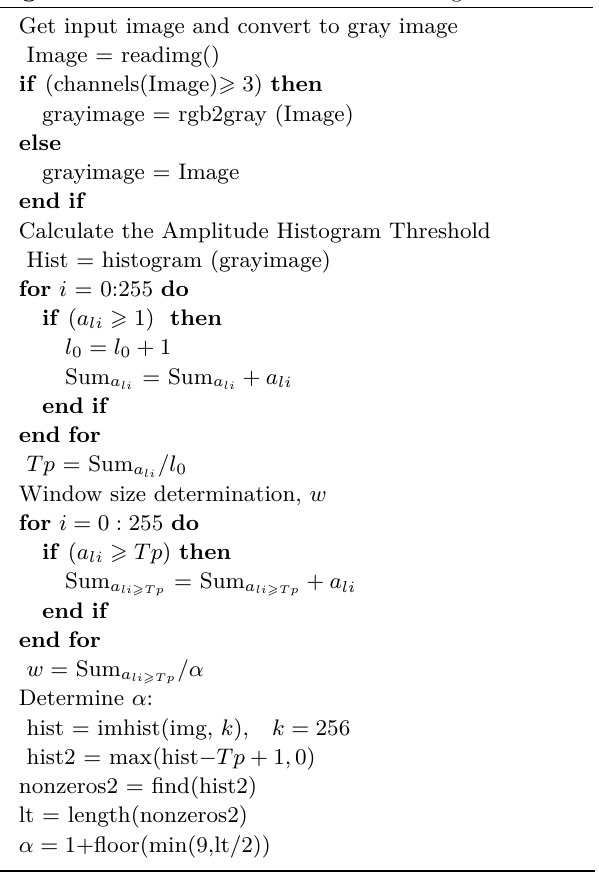
Algorithm 1 Pseudocode for window size generation